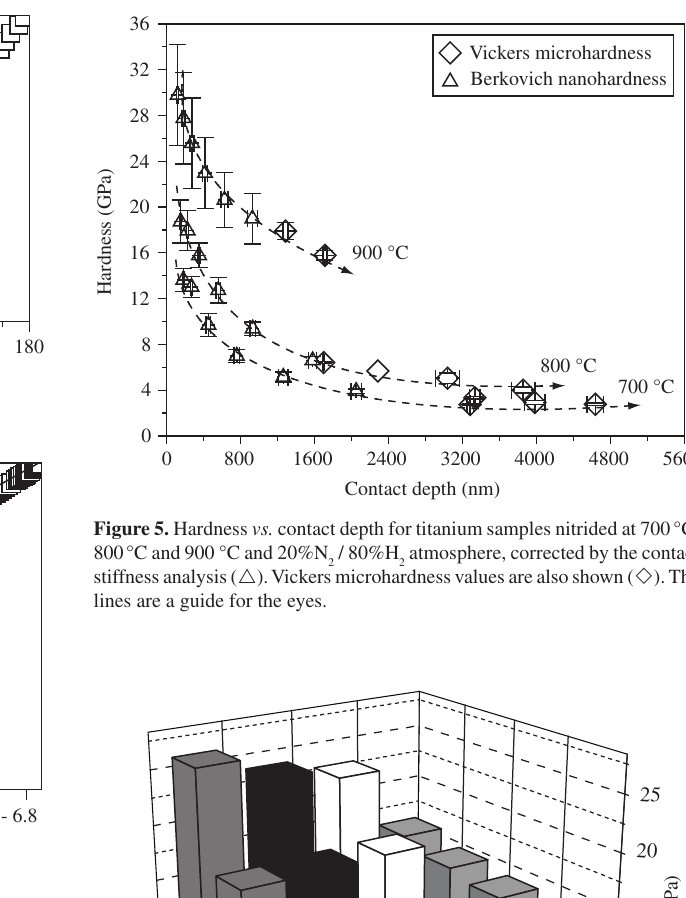
/ 40%H atmosphere 2 2